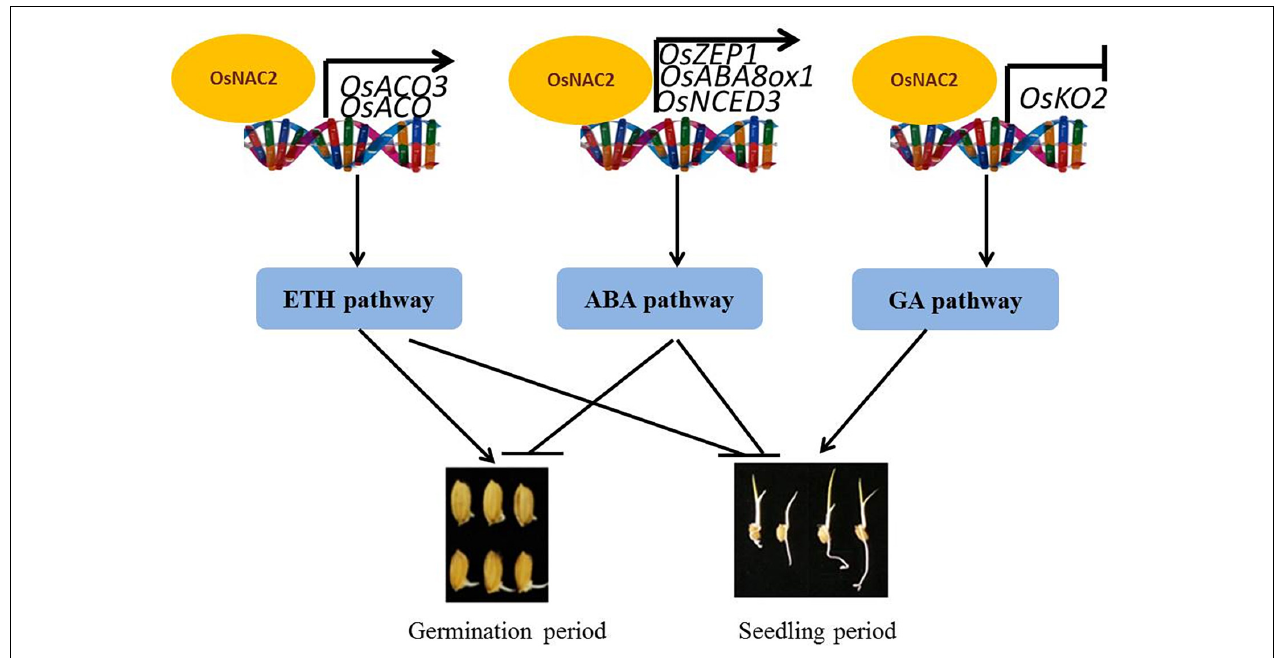
FIGURE 7 | Working model of OsNAC2 in rice seed and seedling